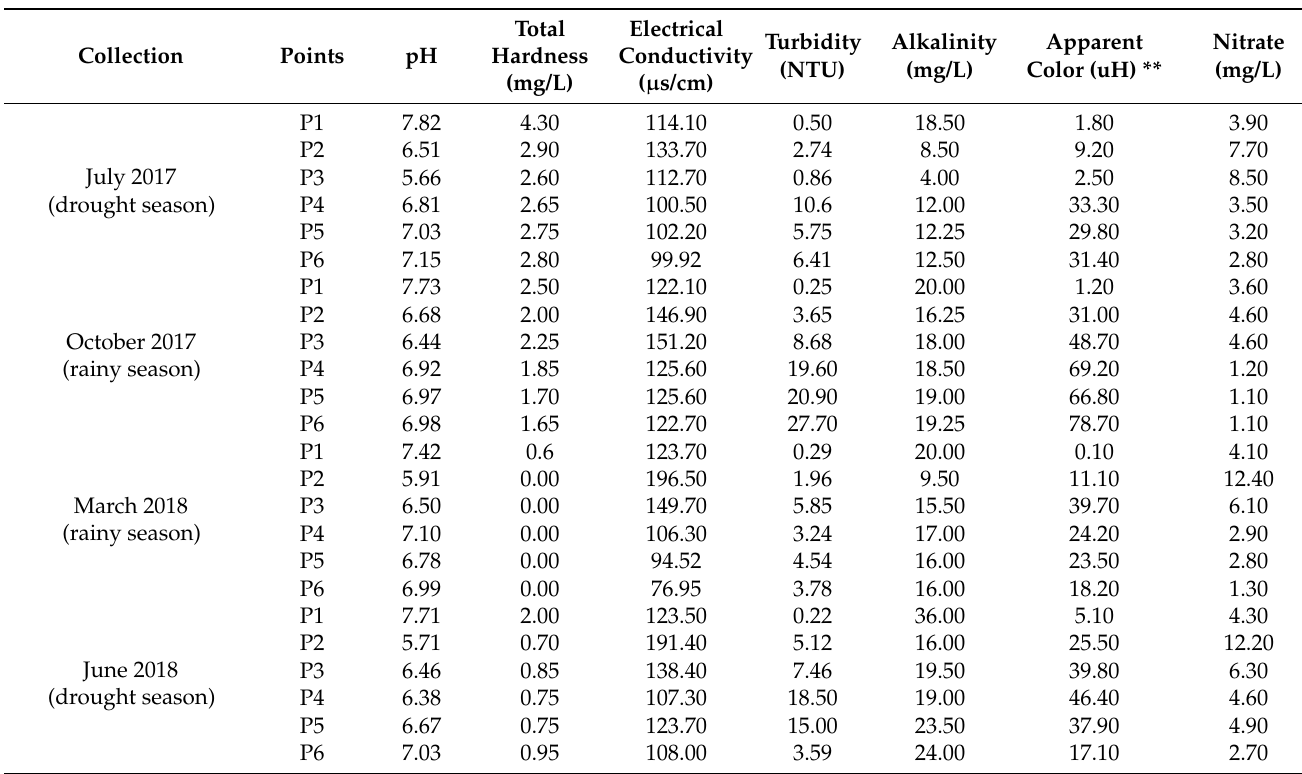
Table 1. Results obtained from physical and chemical analyzes of water samples from the source of Buritis Lake and maximum allowed value according